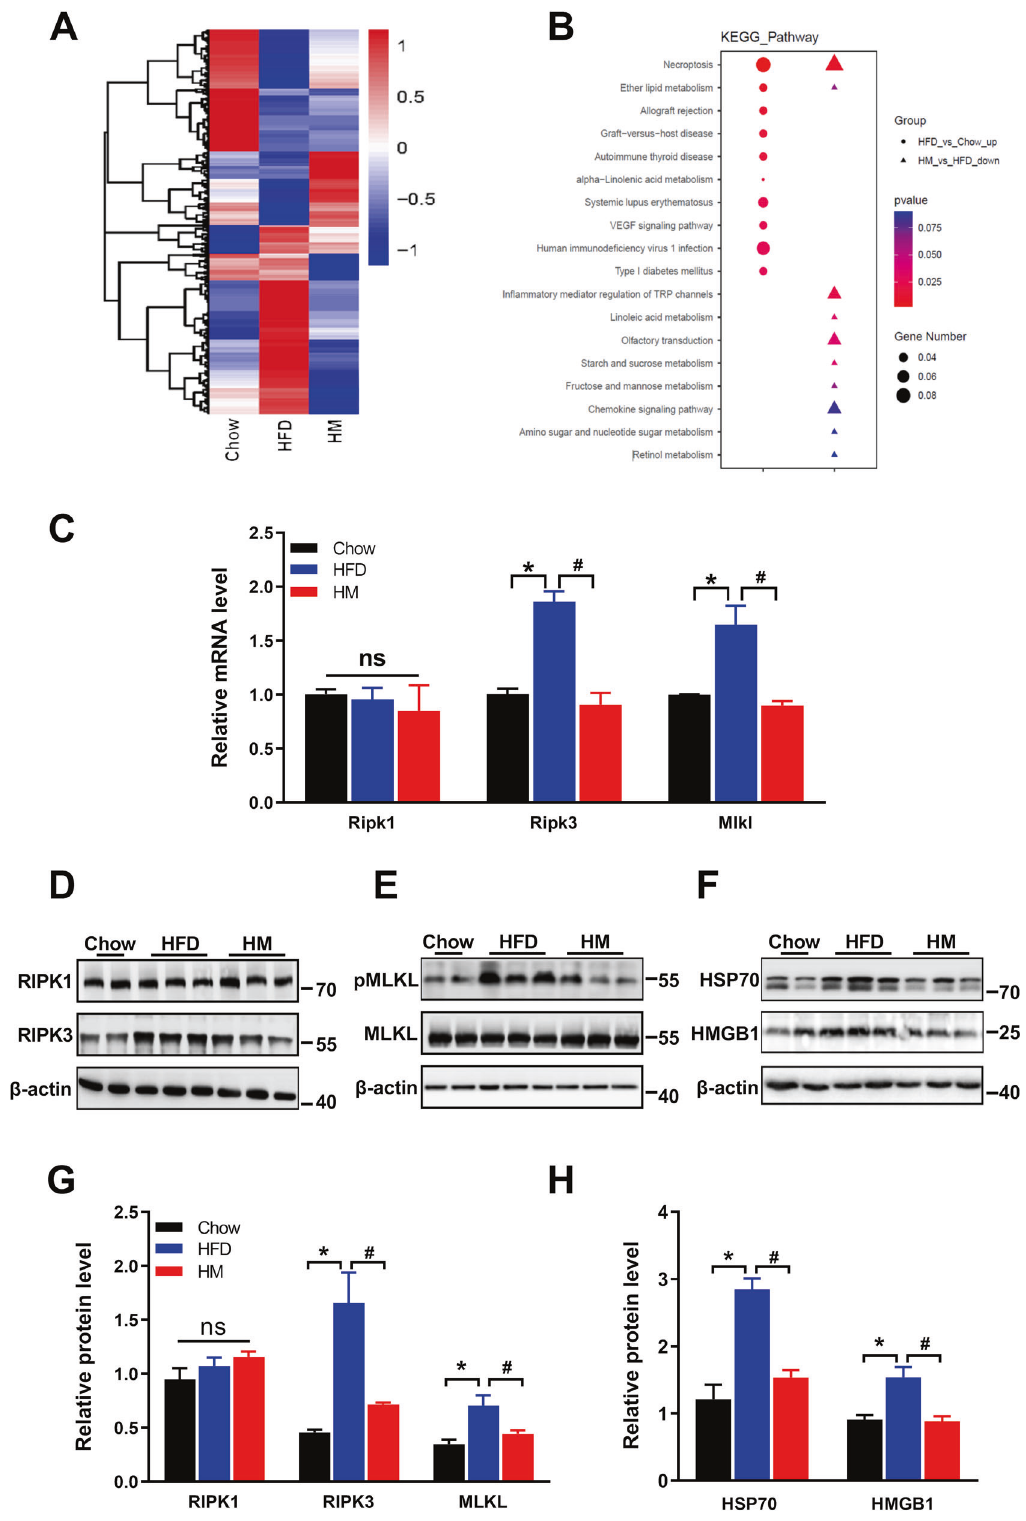
Fig. 1 Necroptosis occurred in the hypothalamus of DIO mice, and metformin suppresses the process of necroptosis. A Heat map of RNA- Seq data showed changes of hypothalamic genes in Chow ( n = 4), HFD ( n = 4), and metformin-treated mice (300 mg/kg/day for six weeks, HM, n = 4). B Advanced bubble chart revealed the enrichment of differentially expressed genes in signaling pathways. C The mRNA levels of necroptosis biomarkers, Ripk1, Ripk3 , and Mlkl , in the hypothalamus of three groups of mice, are measured by qPCR with independent RNA samples. Increased expression levels of Ripk3 and Mlkl were observed in HFD. Metformin dampened the overexpression of the genes. There was no detectable difference in Ripk1 . D , E and G Immunoblotting data con fi rmed the fi ndings in qPCR ( n = 7 for each group of mice). F and H The upregulated protein expression levels of HSP70 and HMGB1, two DAMPs, validated the necroptosis occurrence in the hypothalamus of obese mice and metformin mitigation of the injury. The data were presented as mean ± SEM. * P < 0.05 vs. Chow mice; # P < 0.05 vs. HFD